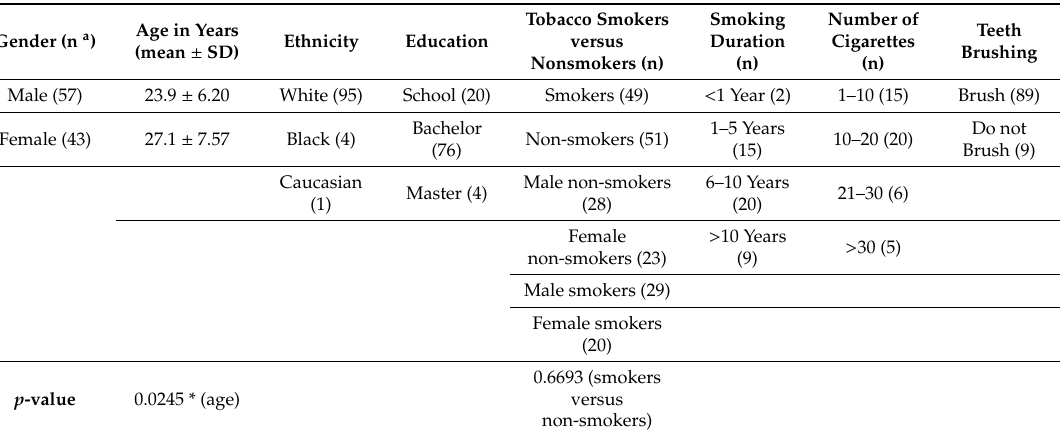
Table 1. Demographic data of the study